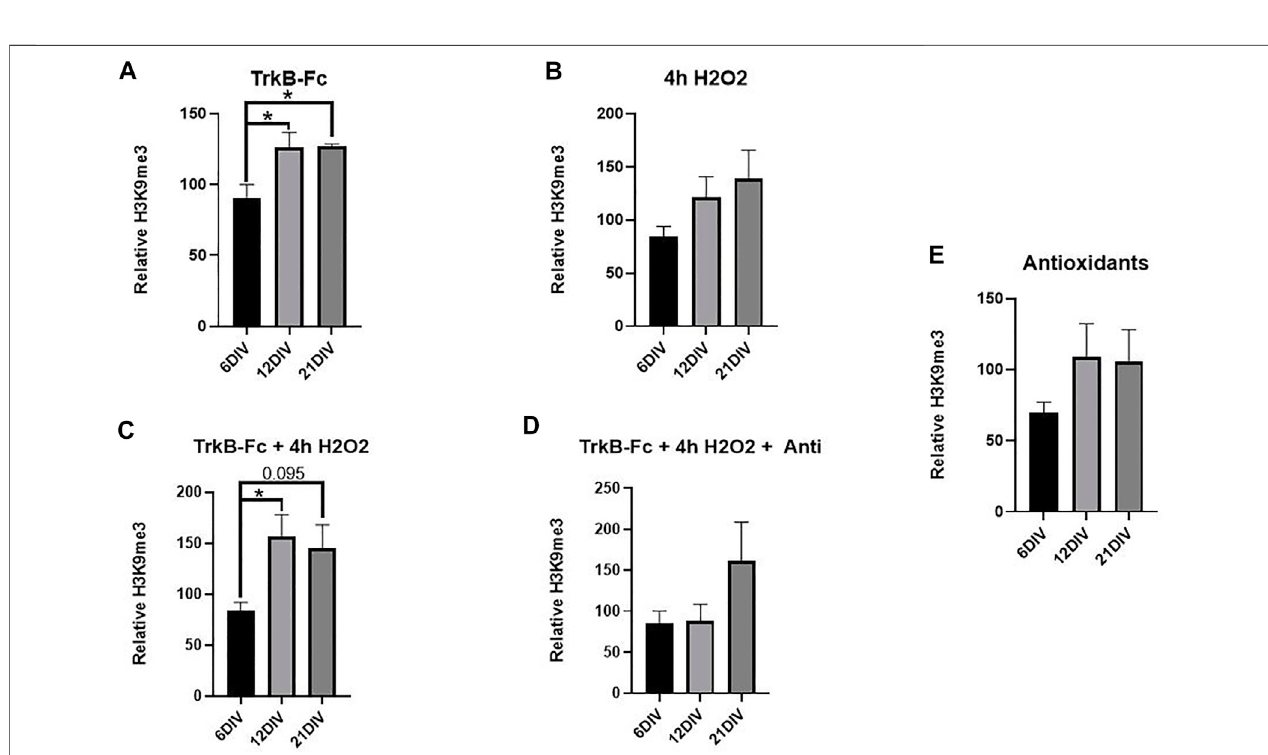
FIGURE 3 | TrkB-Fc Signi fi cantly Elevates H3K9me3 in 12 and 21 DIV Hippocampal Neuron Cultures. 12 and 21 DIV were compared to 6 DIV. Relative H3K9me3 levelsarenormalizedtountreatedcontrolsforeachcultureage. (A) H3K9me3westernblotanalysisofhippocampalneuronculturestreatedwith1 μ g/mlTrkB=TrkB-Fc for 24 h. Welch ’ sANOVA, * p =0.015; n =7for 6DIV, n = 9for12DIV, n =5for21DIV. Dunnet ’ sT3multiplecomparisons test, * p =0.0186DIV vs.21DIV,* p =0.0486 DIV vs. 12 DIV. (B) H3K9me3 western blot analysis of hippocampal neuron cultures treated with 200 μ M H2O2 for 4 h. Welch ’ s ANOVA, p = 0.12; n = 7 for 6 DIV, n = 9 for 12 DIV, n = 5 for 21 DIV. (C) H3K9me3 western blot analysis of hippocampal neuron cultures treated with 1 μ g/ml TrkB-Fc for 24 h and 200 μ M H2O2 for 4 h. Welch ’ sANOVA,* p =0.018, n =7for6DIV, n =9for12DIV, n =5for21DIV.Dunnett ’ sT3multiplecomparisonstest,* p =0.0226DIVvs.12DIV, p =0.0956DIVvs.21 DIV. (D) H3K9me3 western blot analysis of hippocampal neurons treated with 1 μ g/ml TrkB-Fc for 24 h, 200 μ M H2O2 for 4 h and antioxidants for 24 h. Welch ’ s ANOVA, p = 0.44; n = 7 for 6 div, n = 4 for 12 DIV and n = 3 for 21 DIV. (E) H3K9me3 western blot analysis of hippocampal neurons treated with antioxidants for 24 h. Welch ’ s ANOVA, p = 0.27; n = 7 for 6 DIV, n = 4 for 12 DIV and n = 3 for 21 DIV.